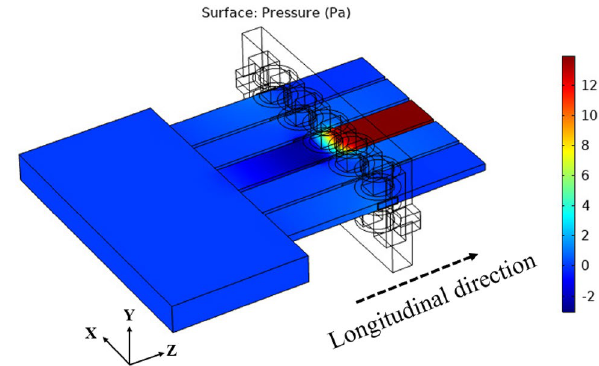
Fig. 10 The contour of the pressure variations in the middle array active mode and the closed channel end